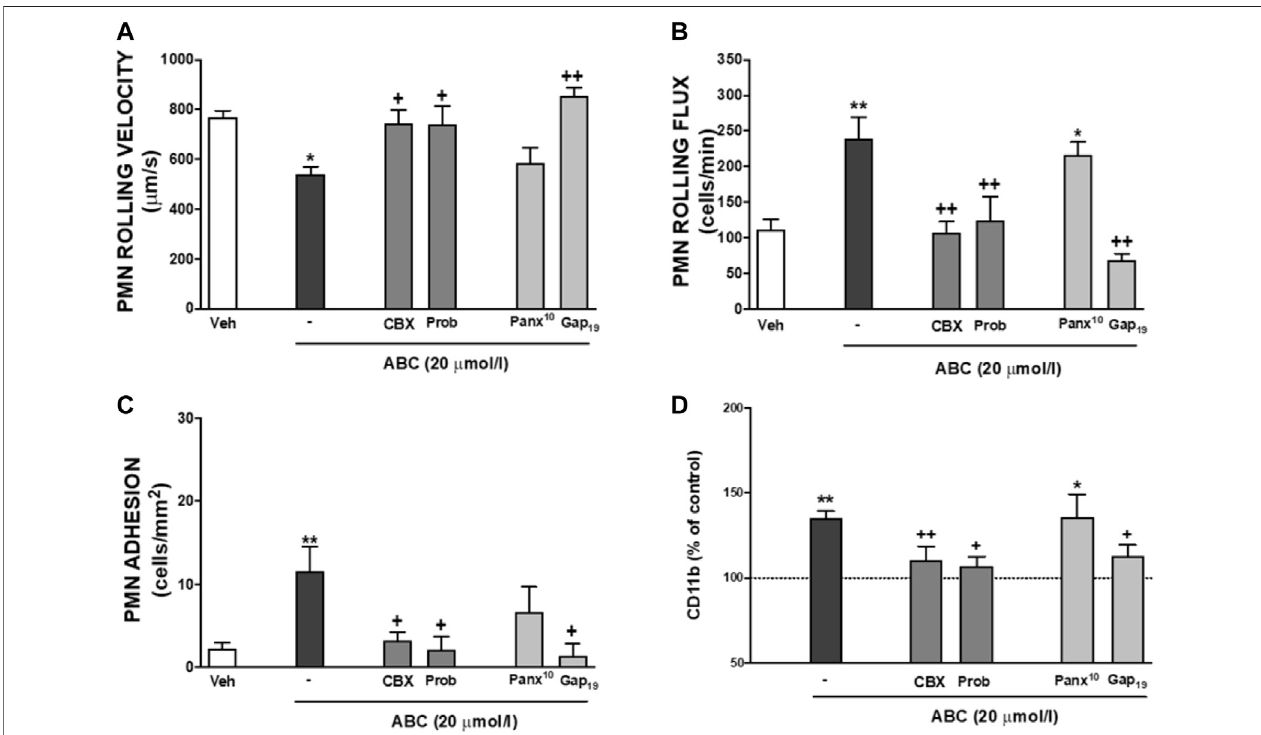
FIGURE5| RoleofendogenousATPreleased bydifferentchannelsonleukocyte-endothelial interactions inducedbyABC.HUVEC andPMNorwholeblood were incubated (4 h) with ABC (20 µmol/L). In some cases, they were pretreated with Carbenexolone (pannexin and connexin channels blocker, CBX, 100 µmol/L), Probenecid (Prob, pannexin and connexin channels and P2X7 receptor blocker, 150 µmol/L), Panx10 (mimetic inhibitory peptide that blocks pannexin-1 gap junctions, 300 µmol/L) or Gap 19 (selective Connexin43 channel blocker Gap 19 , 300 µmol/L). PMN rolling velocity (A) , PMN rolling fl ux (B) and PMN adhesion (C) were quanti fi ed after assembling the fl ow chamber and the expression of one of the two subunits of Mac-1 CD11b (D) on neutrophils was quanti fi ed by fl ow cytometry. Fluorescencevaluesareexpressed aspercentage ofmeanofmedian fl uorescenceintensitiesofcontrol cells(dotted line). Results aremean ± SEM,Veh: n ≥ 7,ABC20: